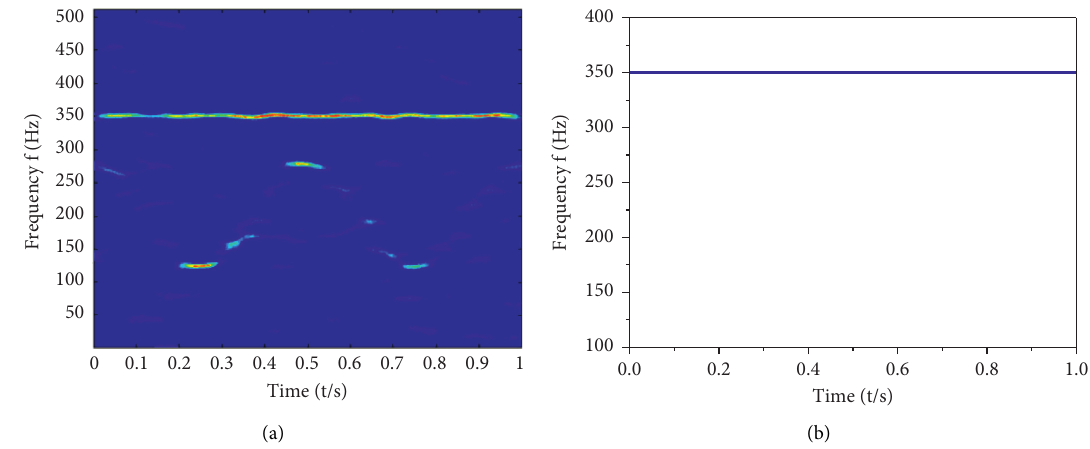
Figure 9: Metric matrix and the ridge lines obtained by the traditional